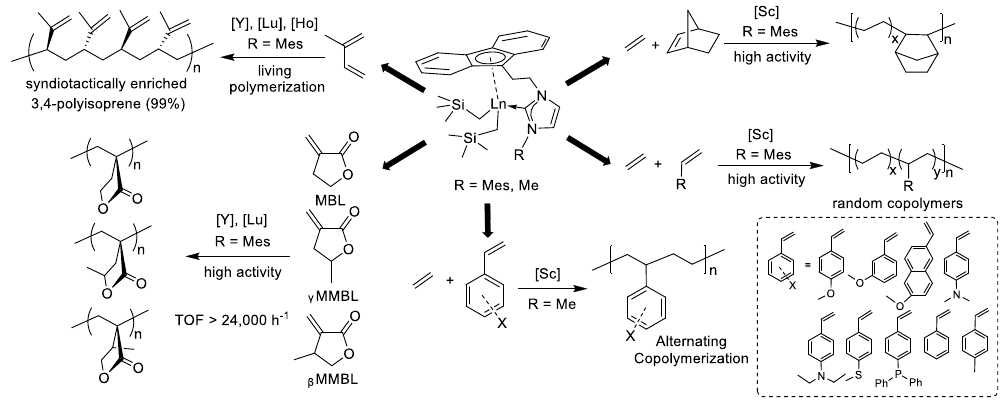
Figure 13. NHC side-armed half-sandwich Ln complexes used for coordination polymerization.